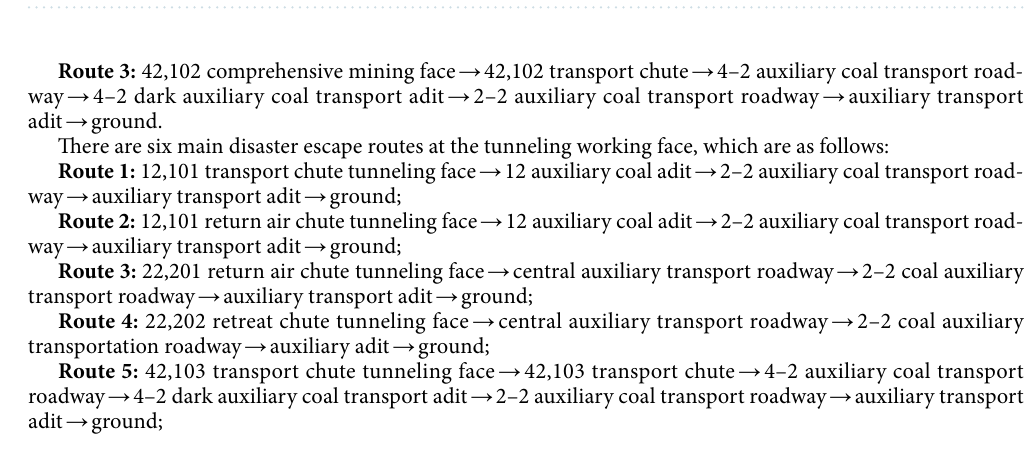
Table 3. Simulation data of dynamic spreading process of fire smoke in Buertai Coal